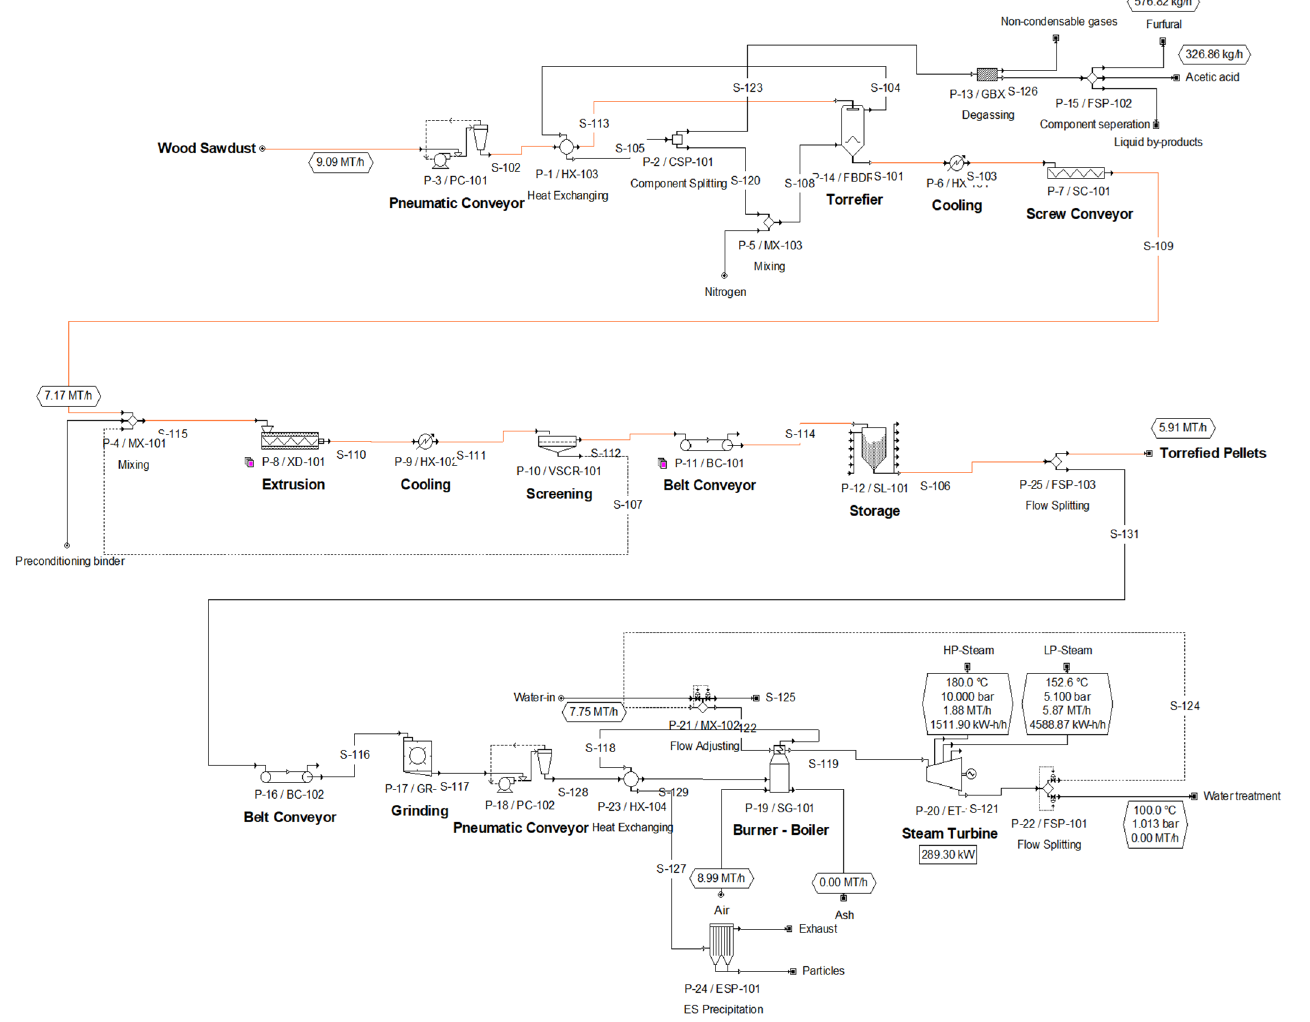
Figure 1. Process flow diagram (PFD) for heat and electricity production from a portion (25%) of torrefied wood pellets (Scenario 4).